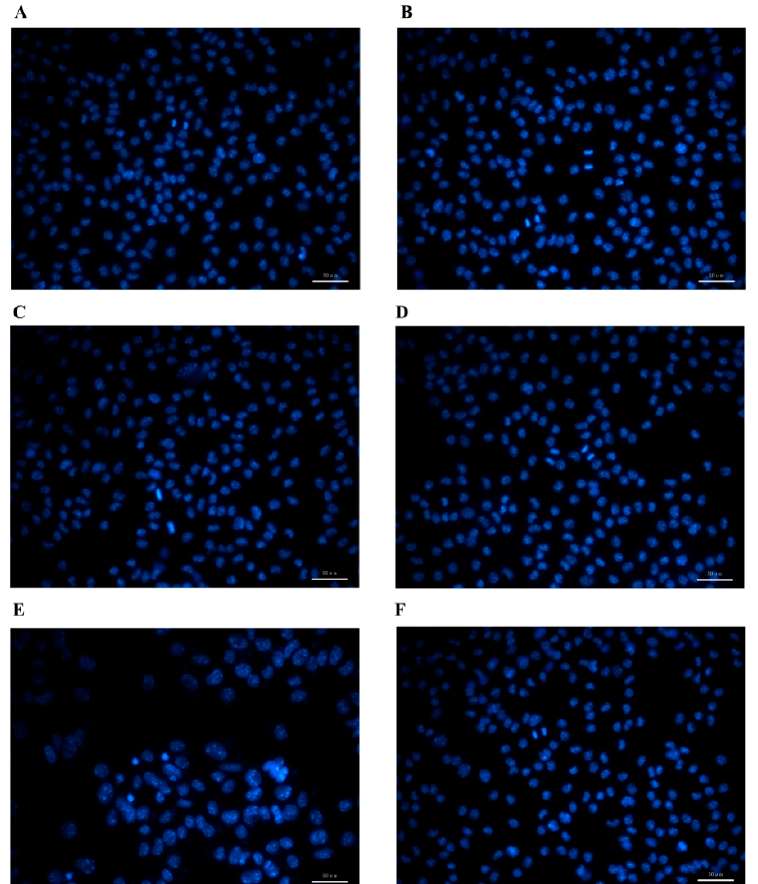
Figure 4. Optical microscopic morphology of B16 cells. PPEO at concentrations of 0, 10, 20, 50, 100 µ g/mL were for ( A – E ), respectively, and kojic acid at a concentration of 71 µ g/mL was for ( F ). Scale bar: 50 µ m